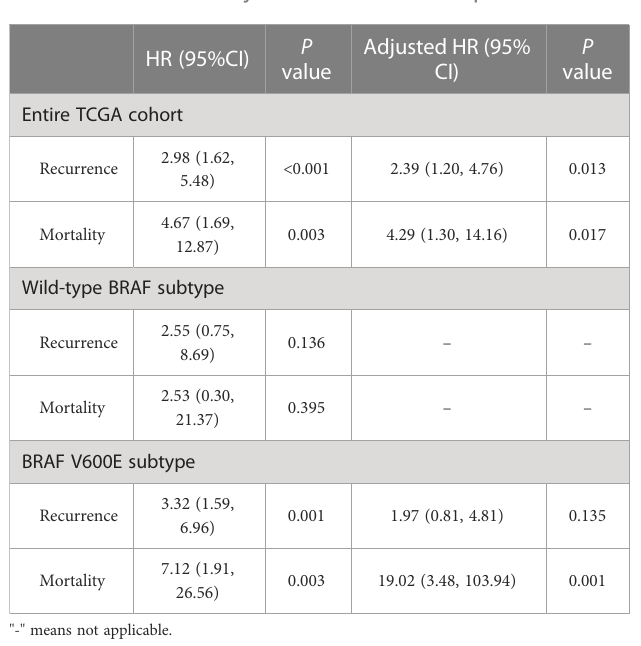
TABLE 3 Hazard ratios of high STRA6 expression vs low STRA6 expression in risk of recurrence and mortality in the THCA cohort with respect to BRAF status.